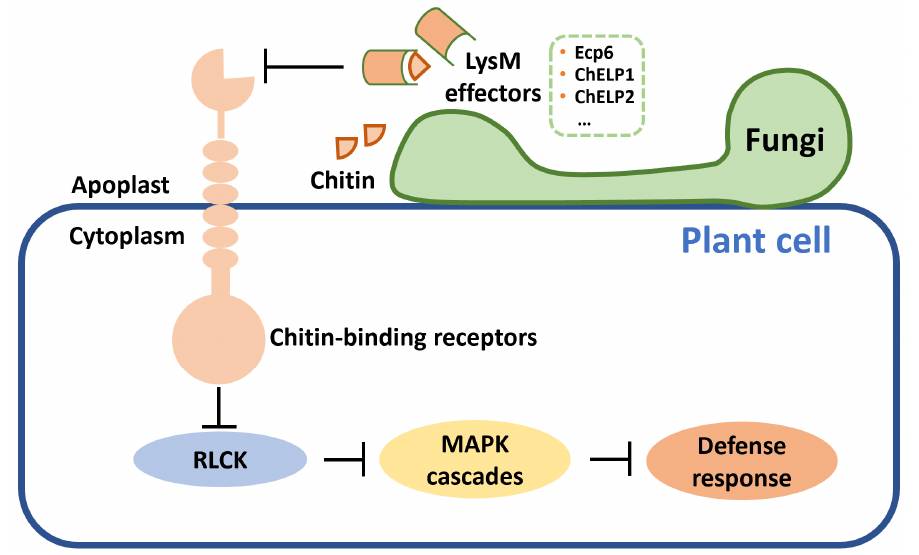
Figure 3. Fungal pathogens secrete LysM effectors blocking chitin sensing and suppress host defense response. LysM: lysin motifs; RLCK: receptor-like cytoplasmic kinases; MAPK: mitogen-activated protein kinase.